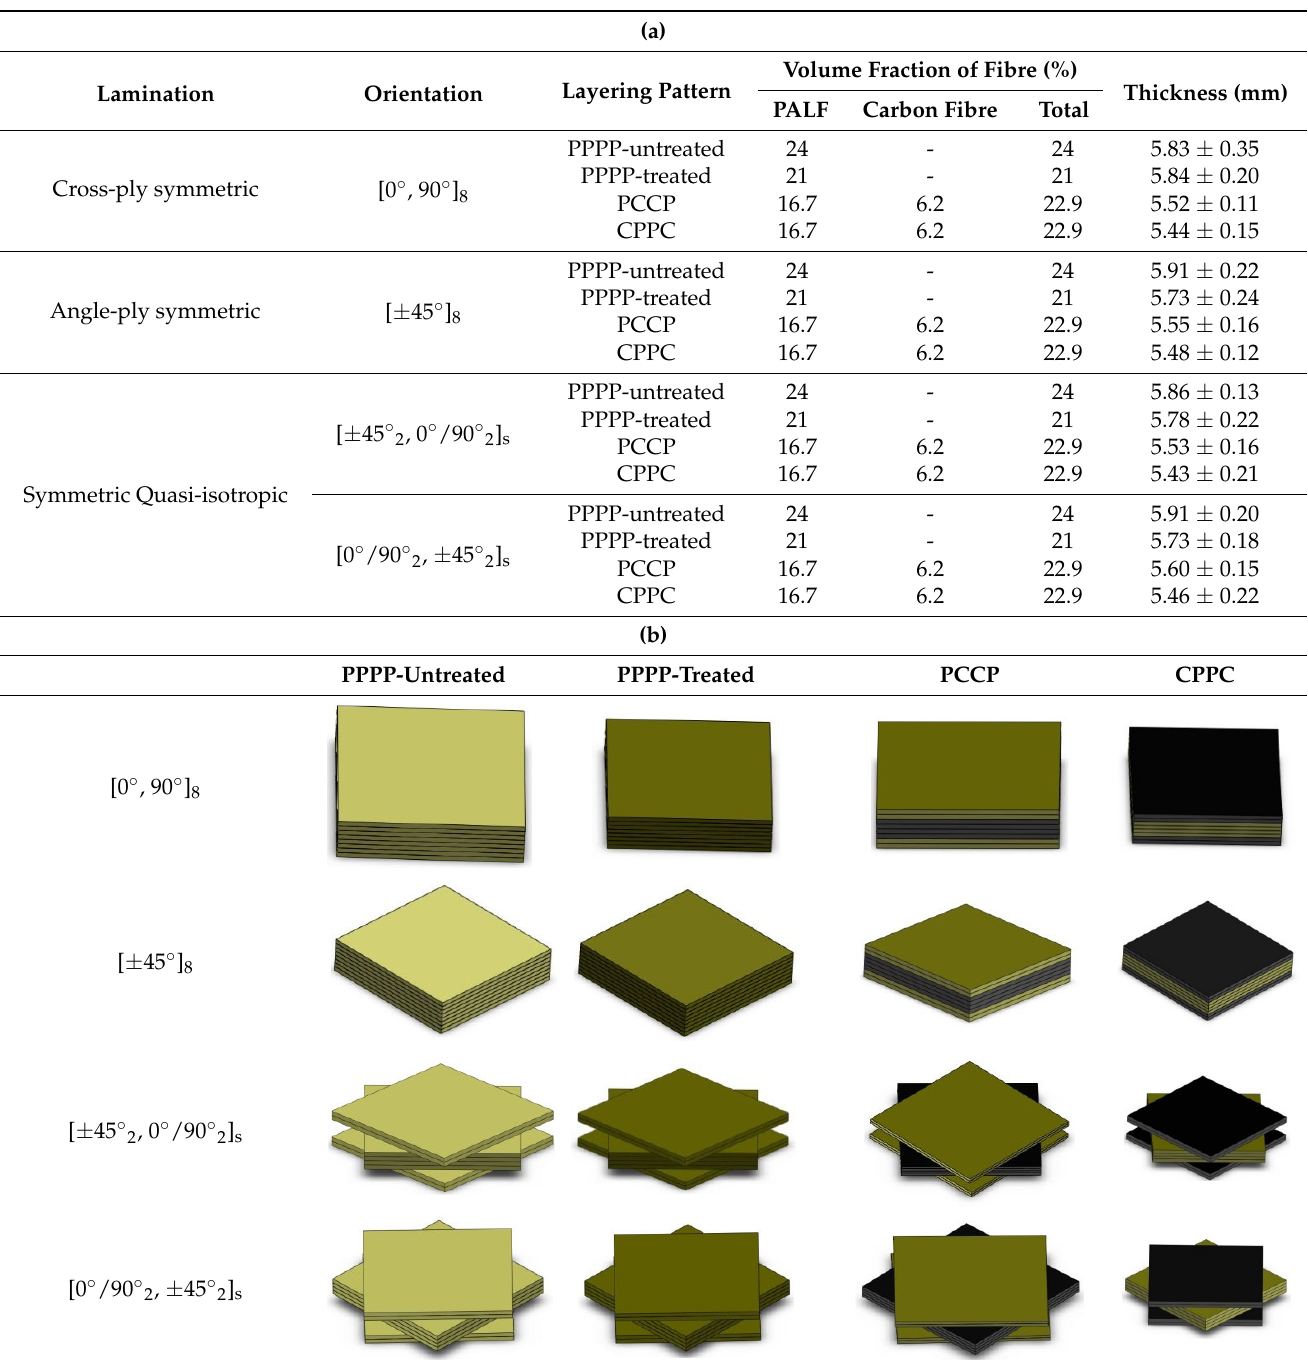
Table 2. (a) Layering sequence of the laminates: PALF (P) and carbon fibre (C). (b) Illustration of layering sequences.